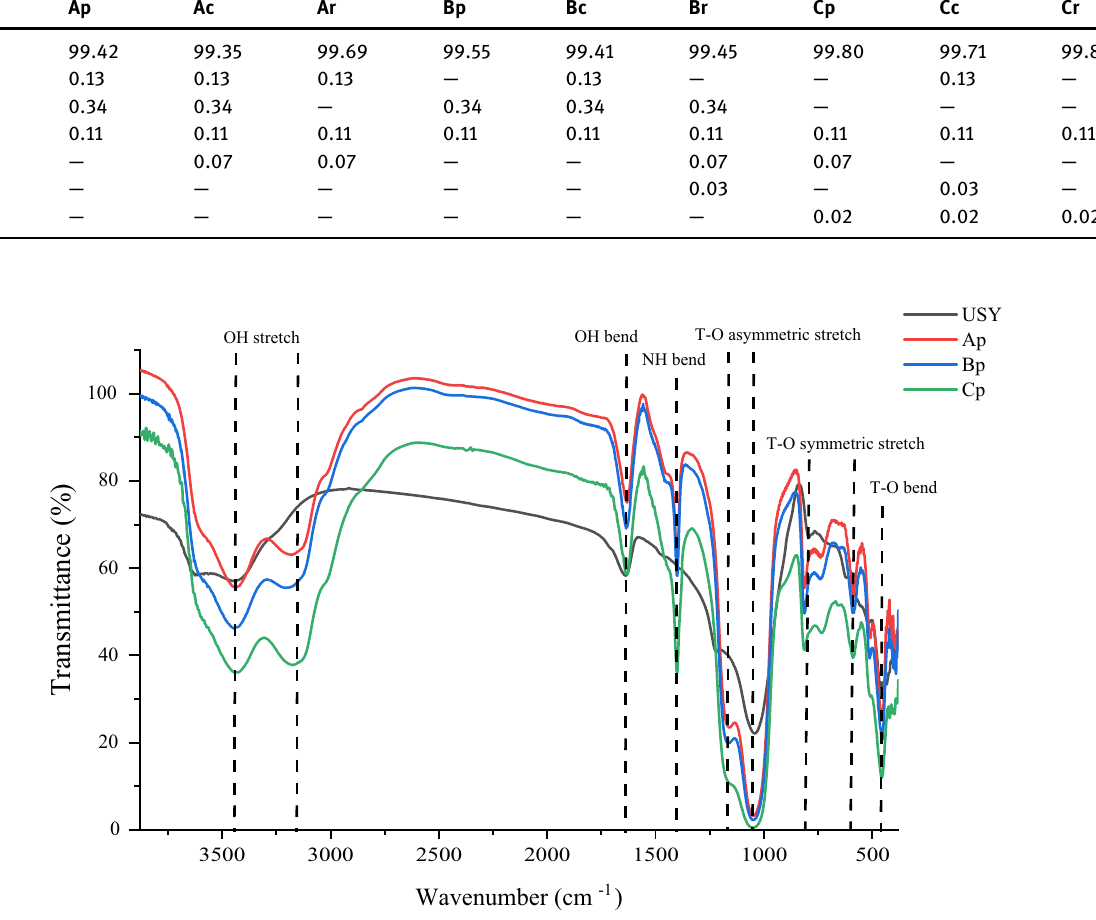
Figure 2: FTIR spectra of catalyst after impregnation